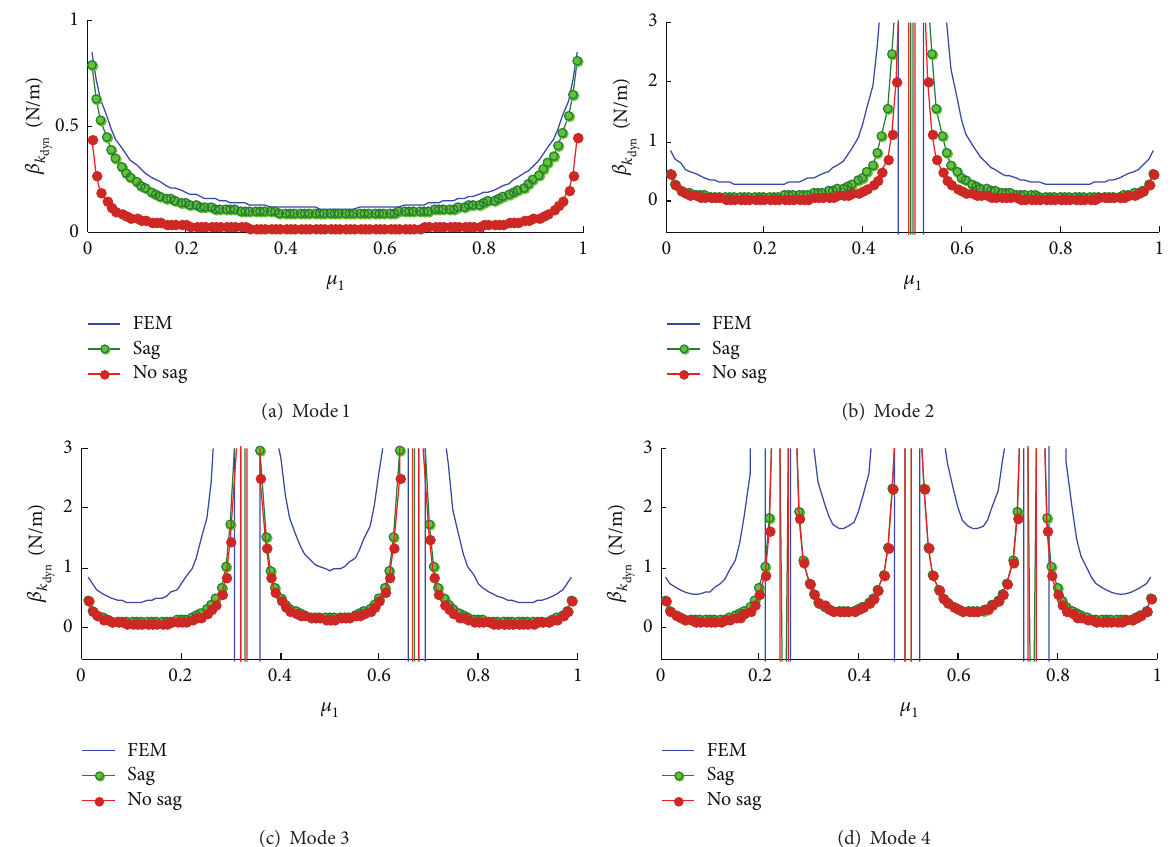
Figure 9: A comparison between the dynamic stiffness of cables with a single transverse degree of freedom using different methods ( 𝜔 = ,𝜔 𝑠 ,𝜔 𝑠 ,𝜔 𝑠 𝜔 𝑠 1 2 3 4 ).